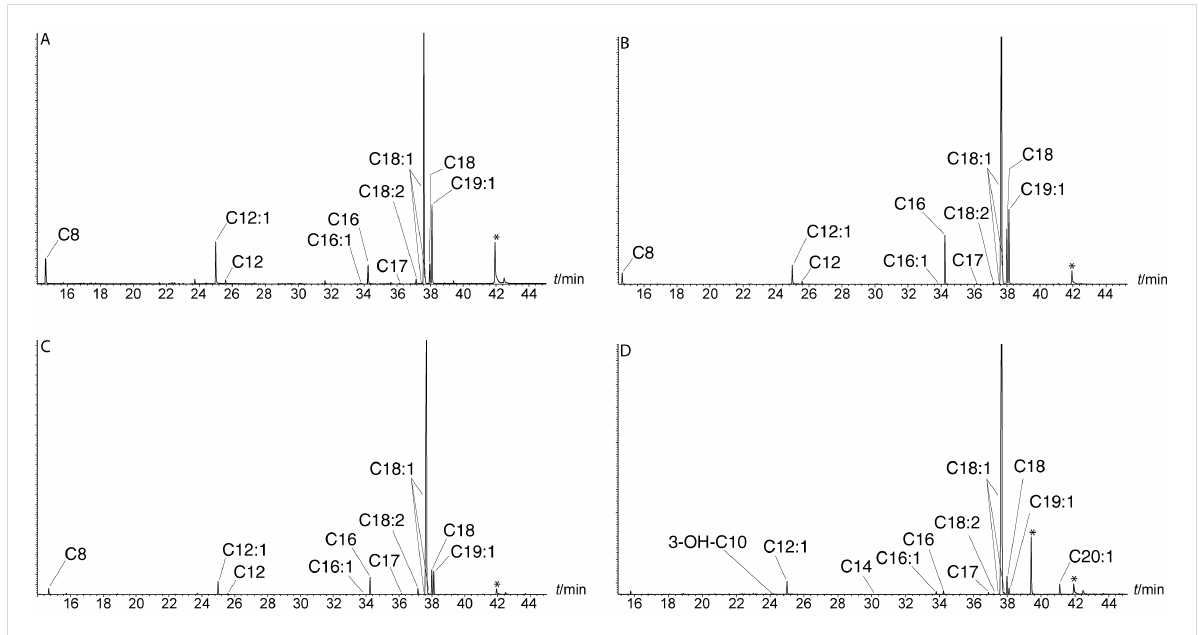
Figure 1: Total ion chromatograms of the FAME extracts of A) P. inhibens 2.10, B) P. inhibens DSM17395, C) P. inhibens T5 and D) D. shibae DFL- 12. *other compounds.